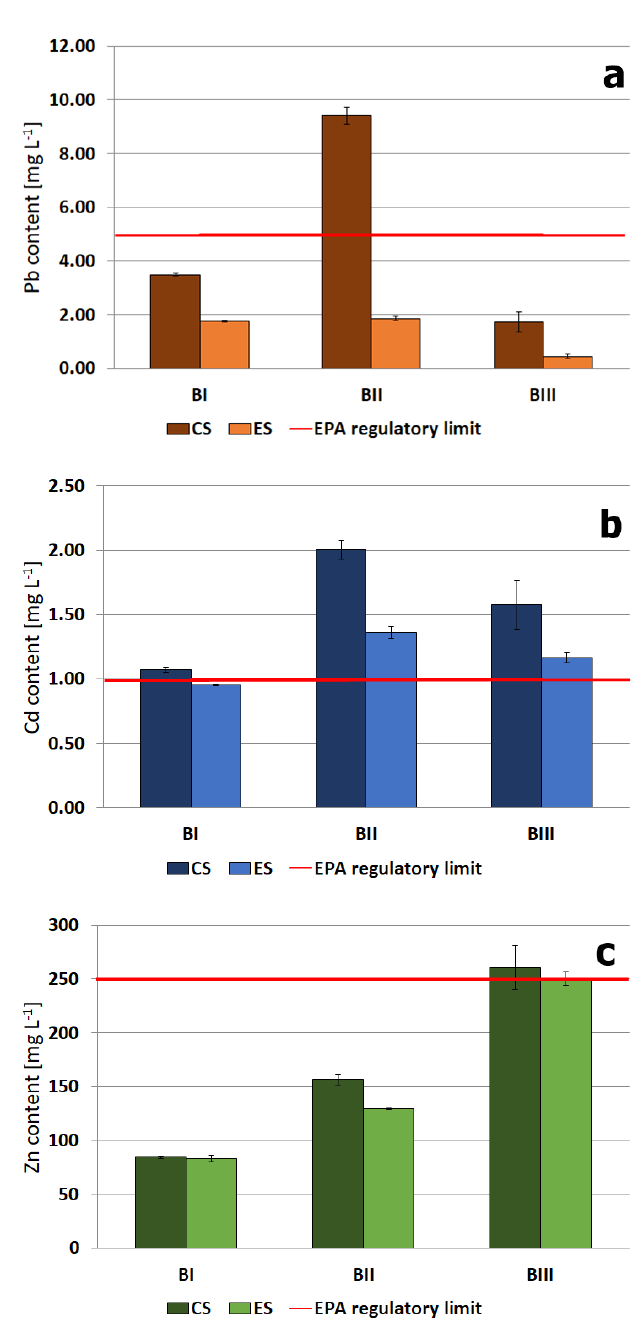
Figure 3. Content of Pb ( a ), Cd ( b ) and Zn ( c ) in soil samples (ES—results for the experimental system, CS—results for the control system). Data based on TCLP.